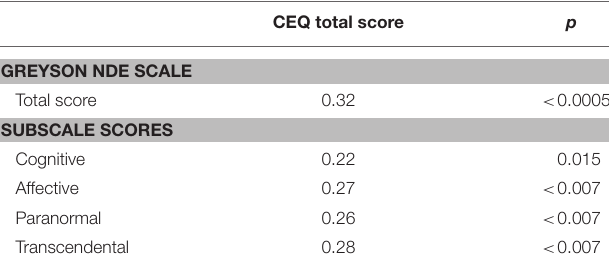
TABLE 3 | Spearman rank correlations between CEQ total score and Greyson NDE scale scores and subscale scores for the total sample ( n =